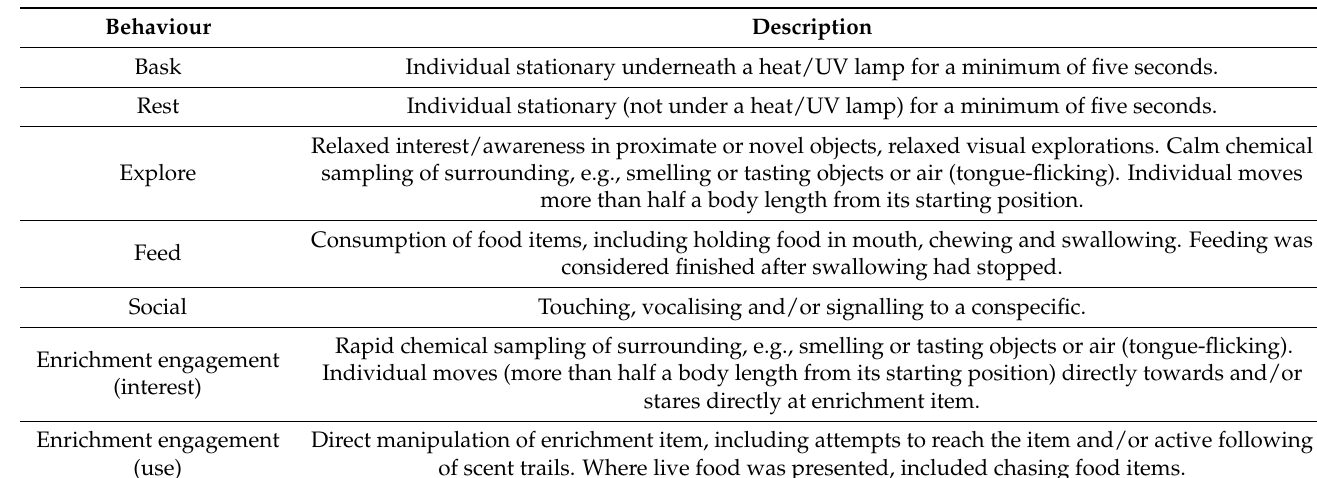
Table 2. Varanid lizard